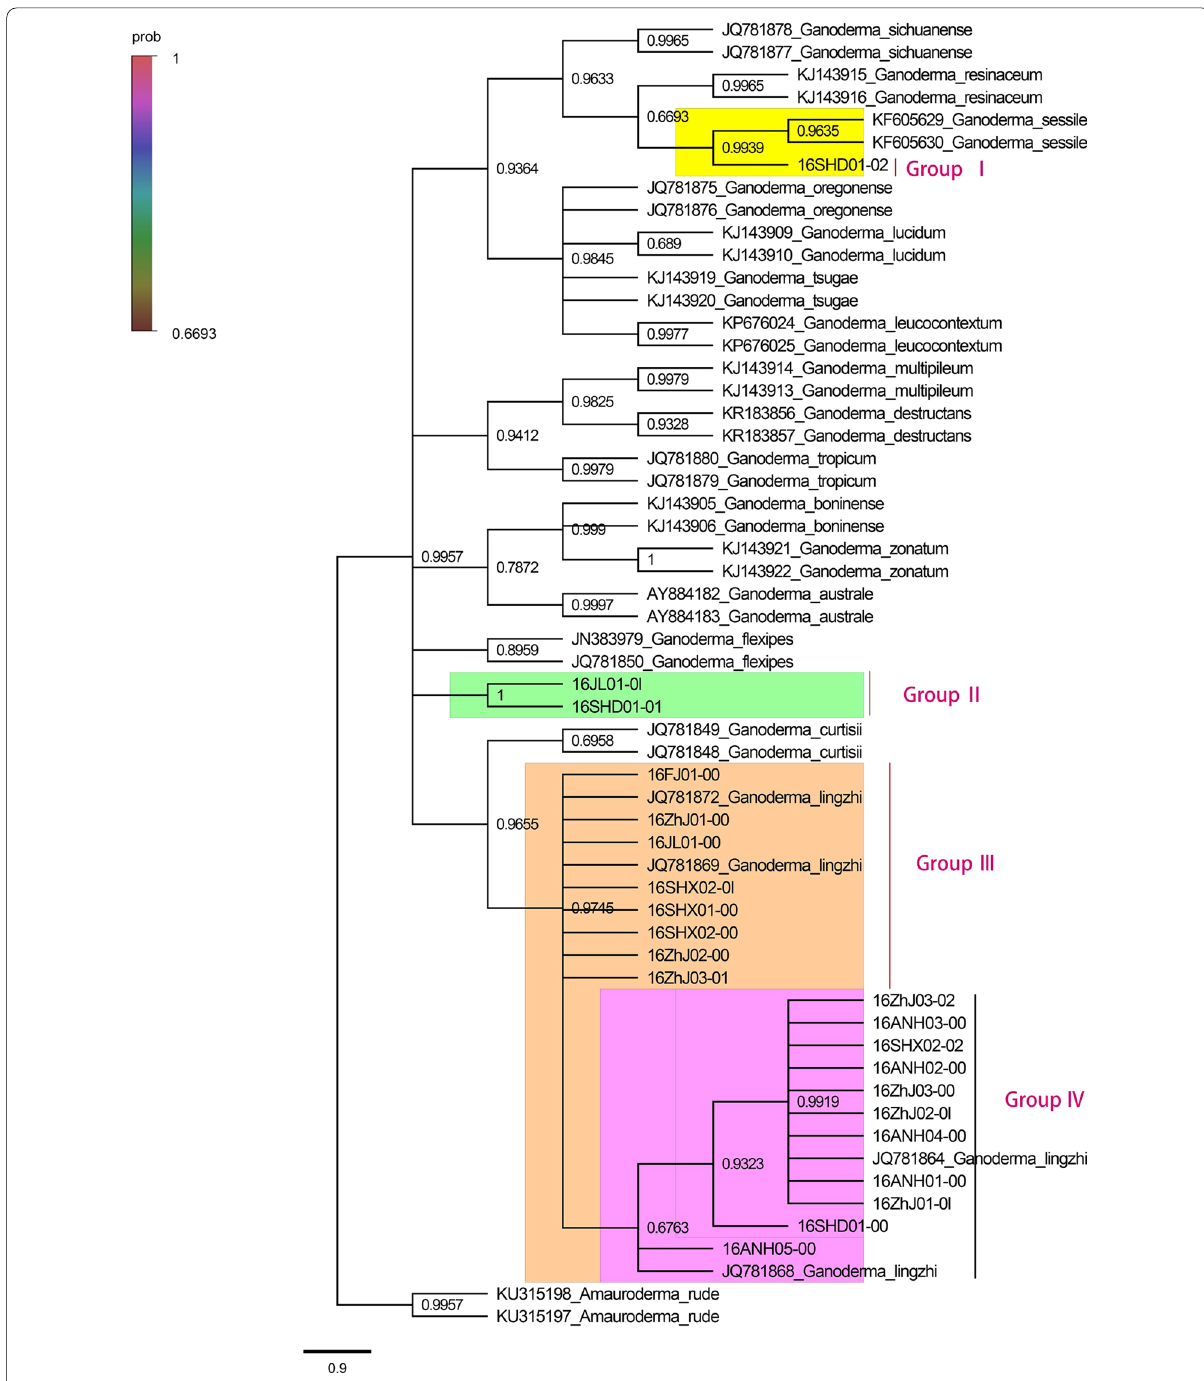
Fig. 1 Phylogenetic tree of 22 lingzhi strains based on ITS